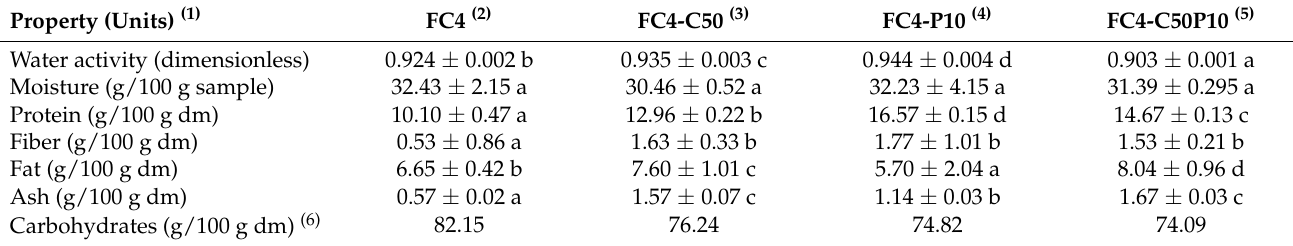
Table 8. Chemical composition of the optimal fresh cooked pastas, based on the egg